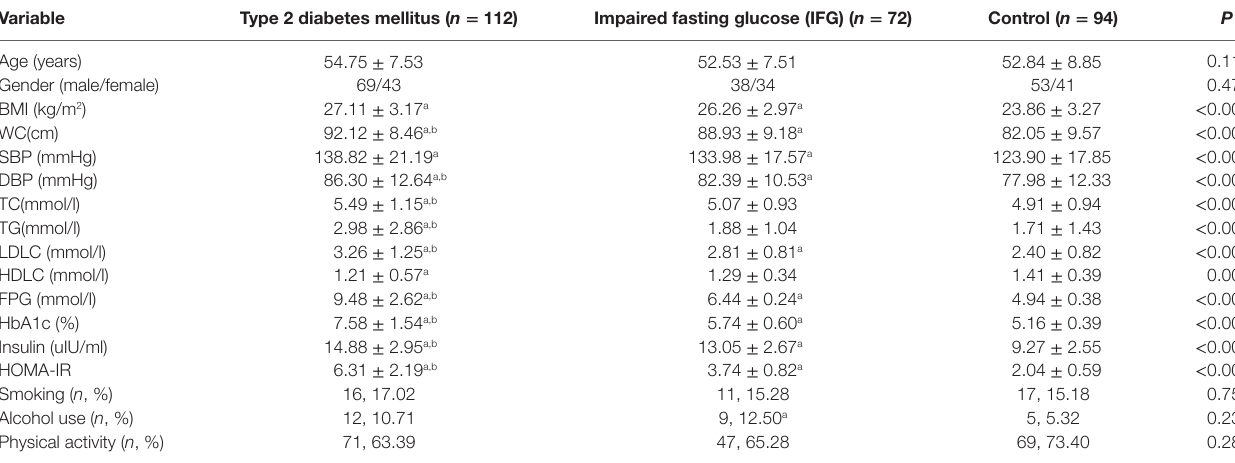
TaBle 3 | Demographic and clinical characteristics of study participants in the validation study. Variable